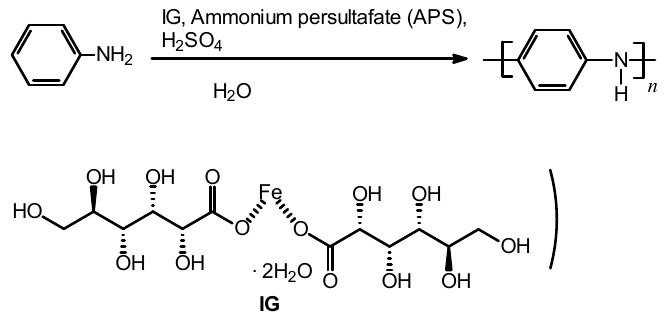
Scheme 1. Synthesis for polyaniline–iron gluconate composite (labeled IG–PANI). Molecular struc-